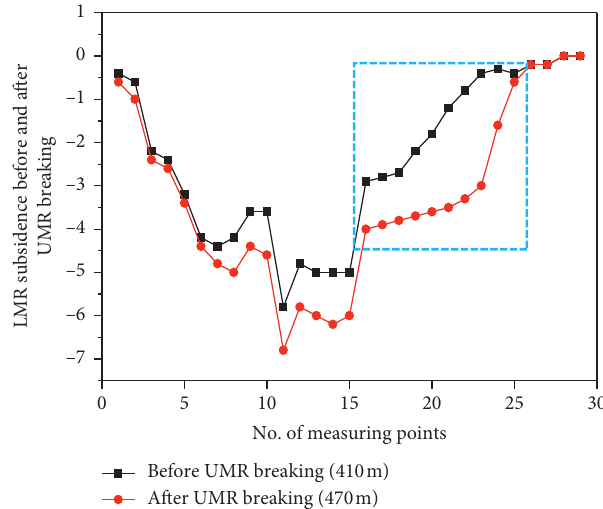
Figure 9: Effect of UMR on LMR before and after UMR